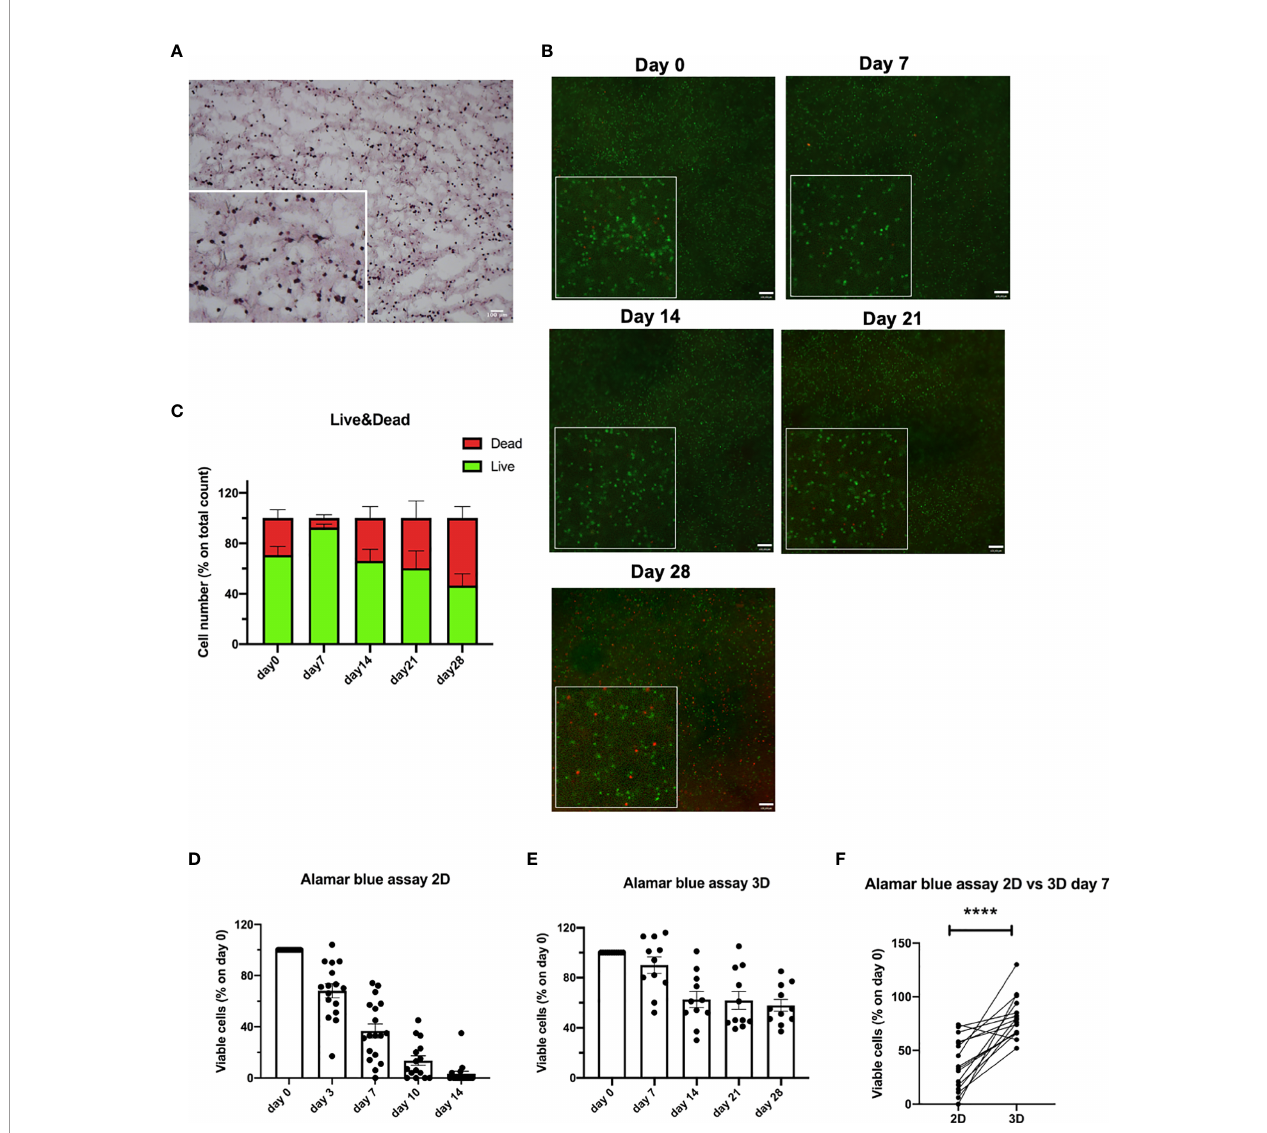
FIGURE 6 | 3D bioprinted CLL primary cells show a long-term viability in the scaffolds. (A) Representative H&E staining on 5 µm frozen sections of 3D bioprinted CLL primary cells showing their distribution in the scaffold. Images were obtained with Zeiss Axio Imager M2m microscope. A magni fi cation of the image is shown. (B) Representative images of Live/Dead assay of 3D bioprinted CLL primary cells at different time points (day 0-7-14-21-28) acquired with Axio Observer Zeiss fl uorescent microscope. Green cells are live cells; red cells are dead cells. A magni fi cation for each image is shown. (C) The graph shows quanti fi cation, at different time points (day 0-7-14-21-28), of alive (green column portion) and dead (red column portion) 3D bioprinted CLL primary cells. (D) The graph shows Alamar blue assay fl uorescence values of 2D cultured CLL primary cells at different time points (day 0-3-7-10-14). (E) The graph shows Alamar blue assay fl uorescence values of 3D bioprinted CLL primary cells at different time points (day 0-7-14-21-28). (F) The graph shows the percentages of viable 3D bioprinted CLL primary cells compared to CLL primary cells cultured in the traditional 2D system. Cell viability was measured by Alamar blue assay after 7 days of culture and normalized to day 0. ****p < 0.0001. Data are represented as mean ± SEM, n=16 (D, F) and n = 11 (E) patient samples. Paired t-test was performed for statistical